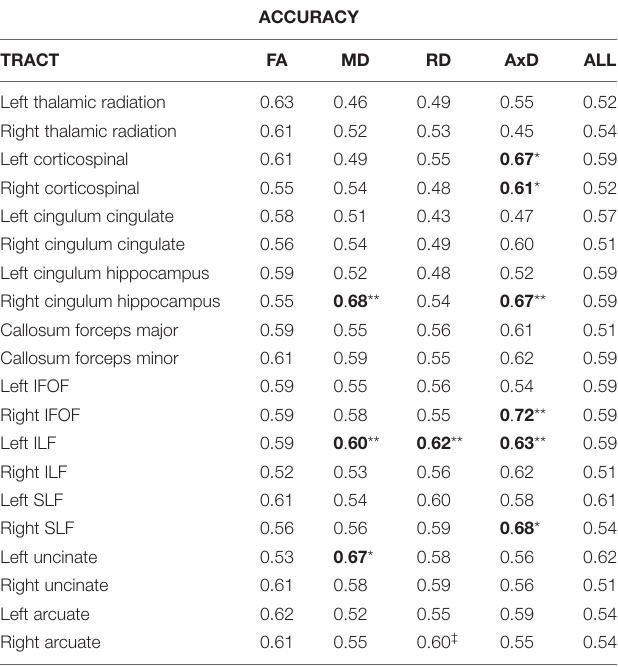
TABLE 2 | SVM classifier accuracies from single tract classification.